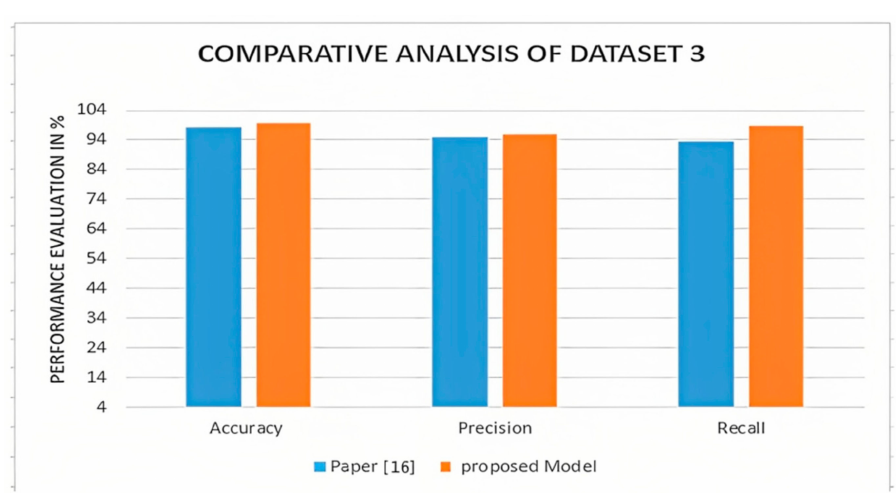
Figure 15. Comparative analysis graph of dataset